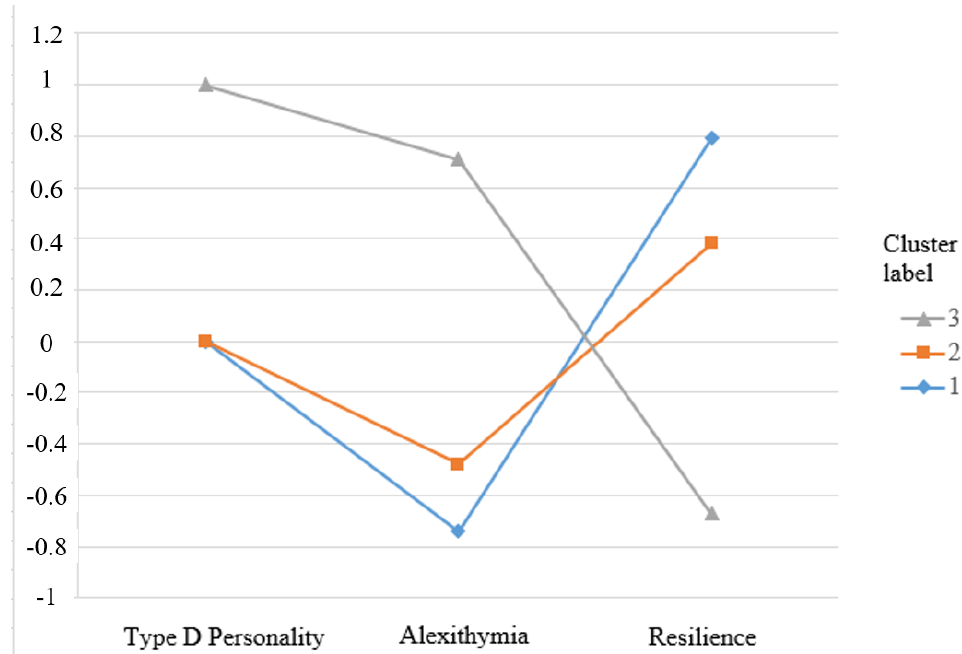
Figure 1. Standardized mean scores of the obtained clusters in the variables of interest. Note: Type D